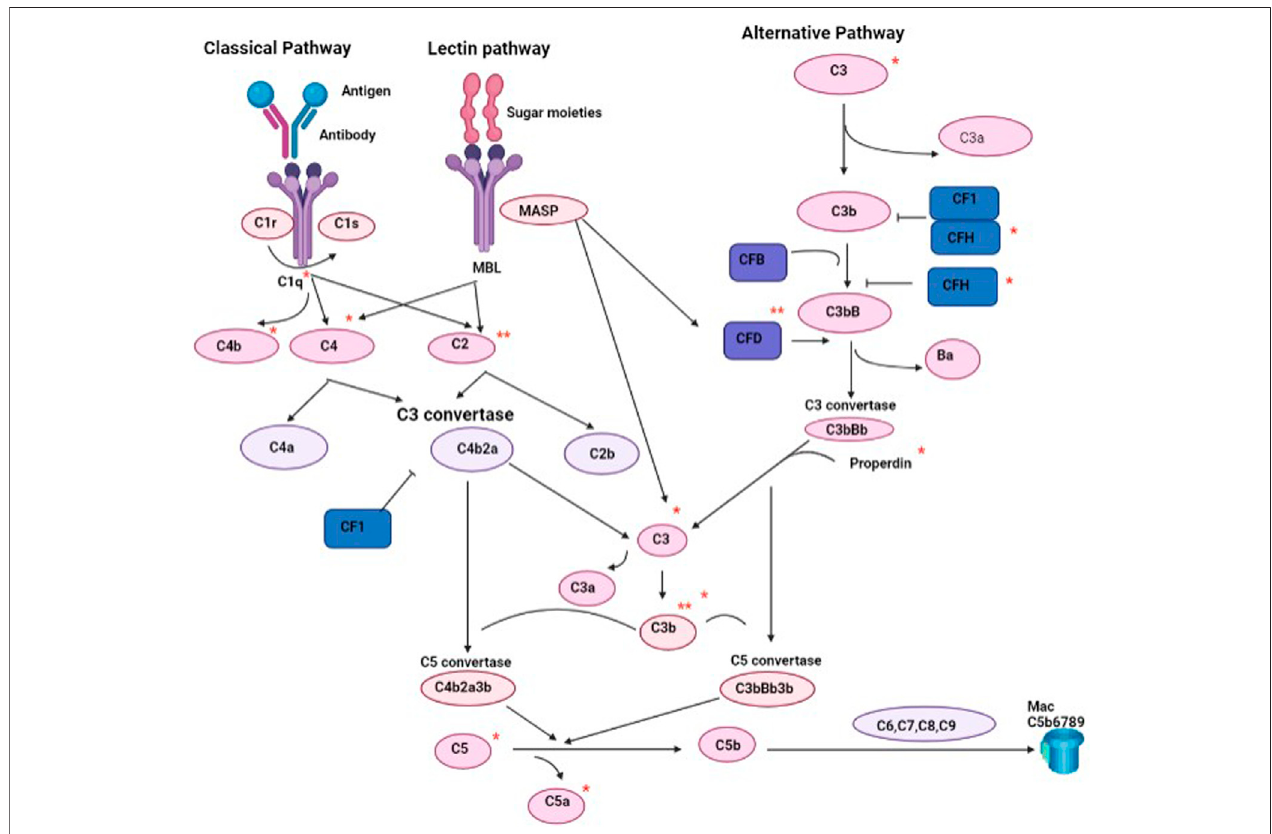
FIGURE5| Aschematicrepresentationofcomplementpathwayshighlightingcomplementsthatwerereducedinhighenduranceathletes(**)andthosereducedin younger high endurance athletes (*). CF (complement factor). CFD